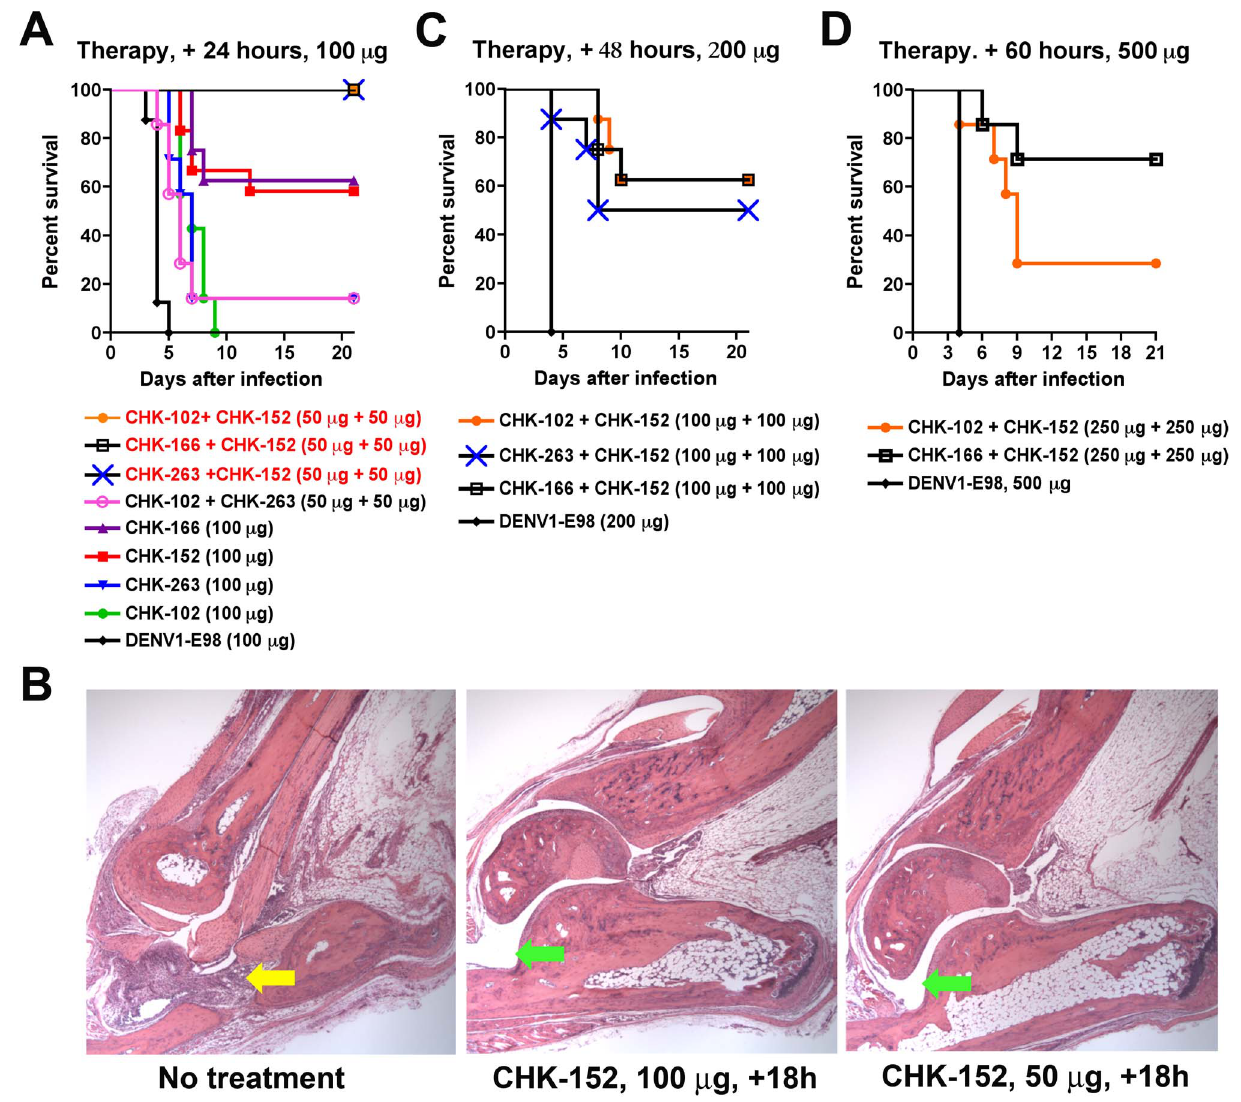
Figure 5. Therapeutic efficacy of anti-CHIKV MAbs. A . Ifnar 2 / 2 mice were passively transferred via an i.p. injection 100 m g of DENV1-E98, CHK- 102, CHK-152, CHK-166, or CHK-263 or 50 m g each of CHK-102 + CHK-152, CHK-166 + CHK-152, CHK-263 + CHK-152, or CHK-102 + CHK-263 at 24 hours after CHIKV infection. B . Five week-old WT C57BL/6 mice were infected with 100 PFU of CHIKV in the footpad and either sham-treated, or treated with 100 or 50 m g of CHK-152 at 18 hours post infection. Virus induced pathology in the foot and ankle joint was assessed by histopathological analysis at day 10 post-infection. ( Left ) CHIKV-infected, sham-treated, ( middle ) CHIKV-infected, CHK-152 (100 m g) treated at + 18 hours, and ( right ) CHIKV-infected, CHK-152 (50 m g) treated at + 18 hours. Shown are representative images after hematoxylin and eosin staining from 3 mice per group at 100 6 magnification. Yellow and green arrows indicate regions of inflammation or normal joints, respectively. C . Ifnar 2 / 2 mice were passively transferred via an i.p. injection 200 m g of DENV1-E98 or 100 m g each of CHK-102 + CHK-152, CHK-166 + CHK-152, or CHK-263 + CHK-152 at 48 hours after CHIKV infection. D . Ifnar 2 / 2 mice were passively transferred via an i.p. injection 500 m g of DENV1-E98 or 250 m g each of CHK-102 + CHK-152 or CHK- 166 + CHK-152 at 60 hours after CHIKV infection. For A , C , and D the survival curves were constructed from data of at least two independent experiments. The number of animals for each antibody ranged from 8 to 10 per group, with the exception of CHK-102 + CHK-263, which was performed with 7 mice only. Statistically significant differences in protection compared to DENV1-E98 are described in the